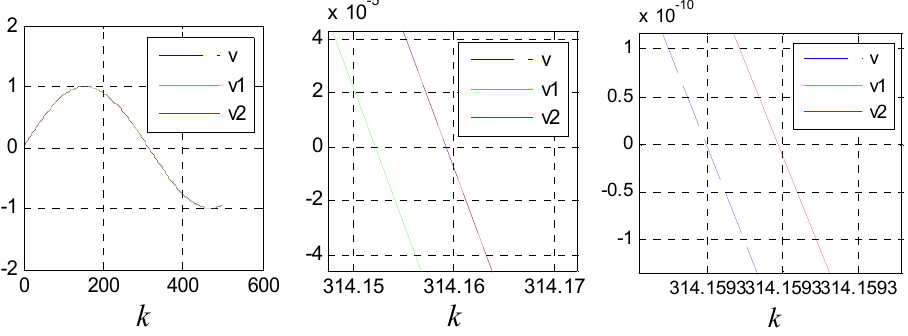
Figure 18. Compensation effect diagram for x